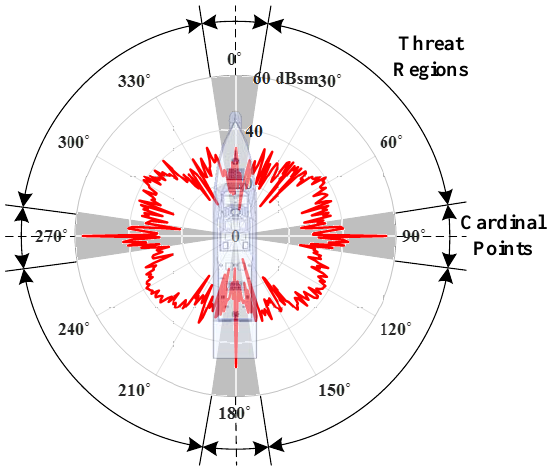
Figure 1. Optimization procedure.